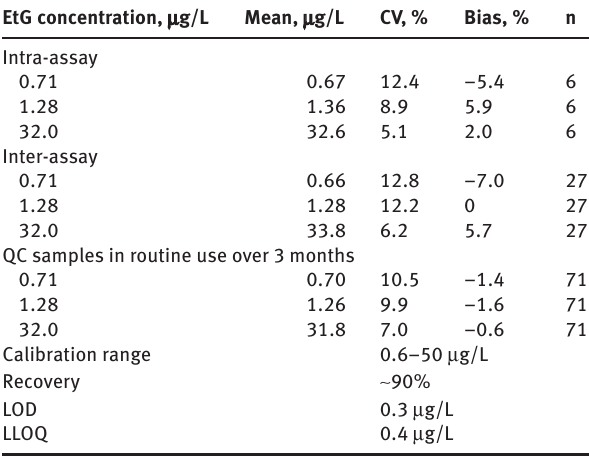
Table 1: Analytical imprecision and accuracy of ethyl glucuronide (EtG) measurement in